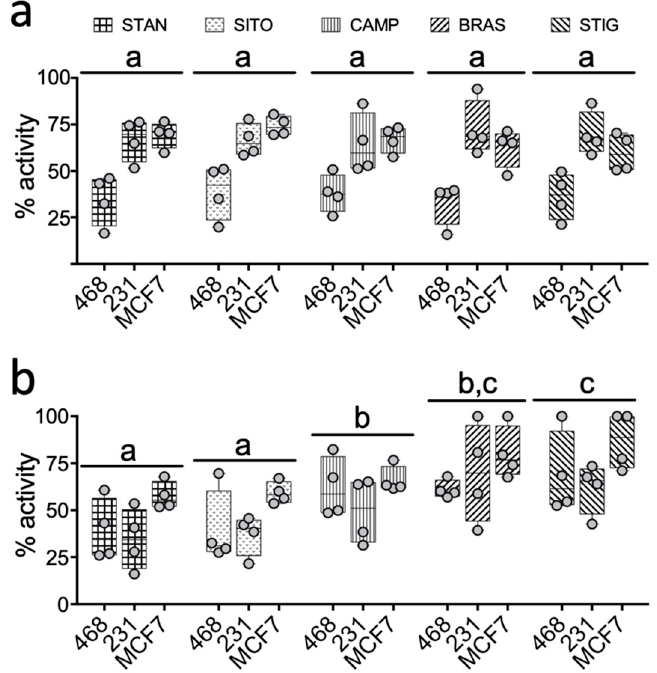
Figure 5. Inhibition of oxysterol induced LXR activity by PSS and cell lines. The percentage efficiency with which each PSS impairs activation of LXR by each oxysterol was calculated in each cell line for both low (1 µM ( a )) and high (10 µM ( b )) dose PSS treatment. Individual oxysterols are represented by circles with range and mean shown in box plots. Statistical differences in the abilities of different PSS to impair oxysterol mediated LXR activation are denoted by different letters (shared letters indicate no significant difference between PSS). Statistical significance was determined using two-way ANOVA.